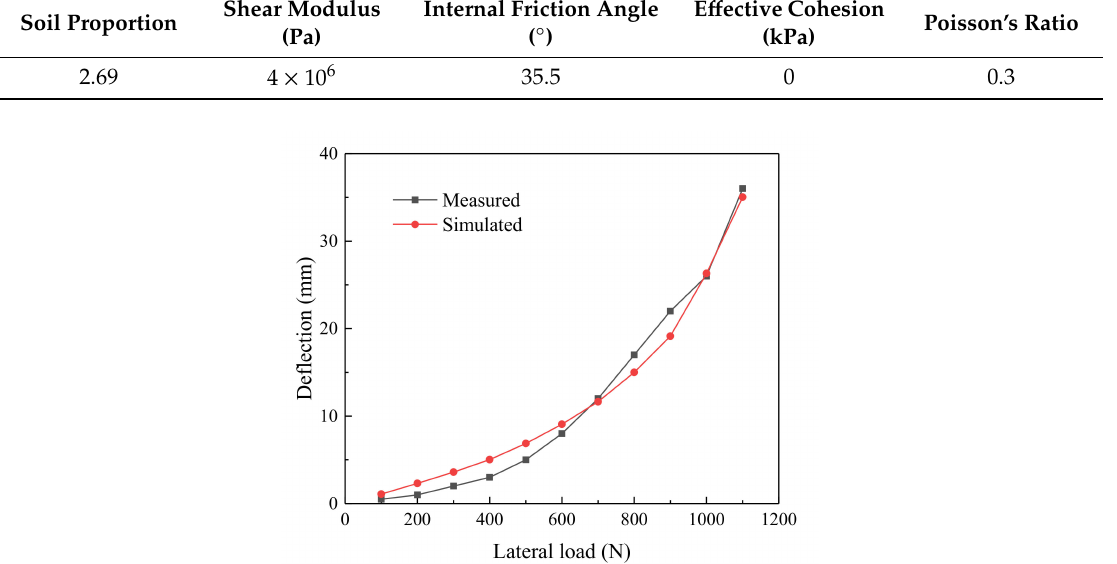
Figure 4. Validation of deflection of monopile against experiment data.